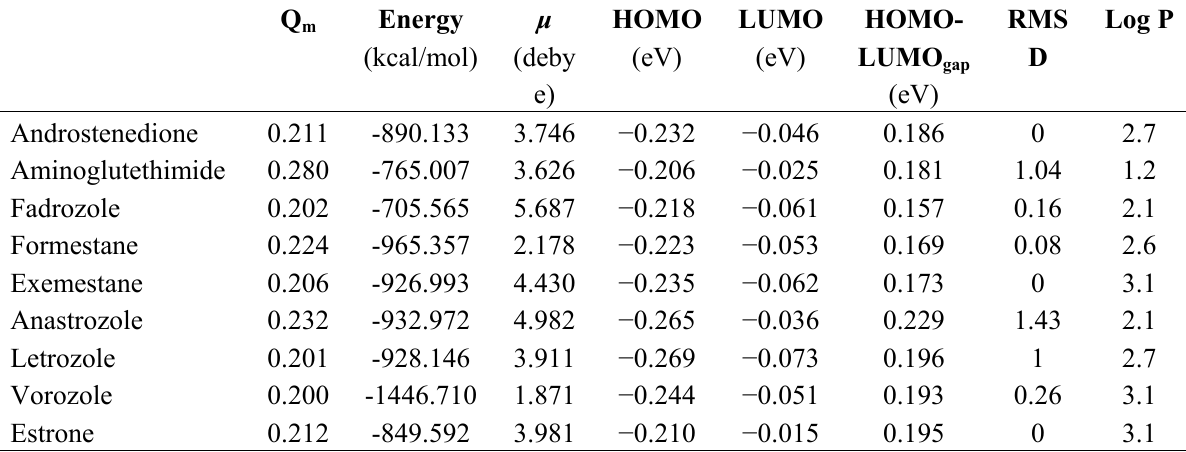
Table 2. Summary of physicochemical descriptors of aromatase